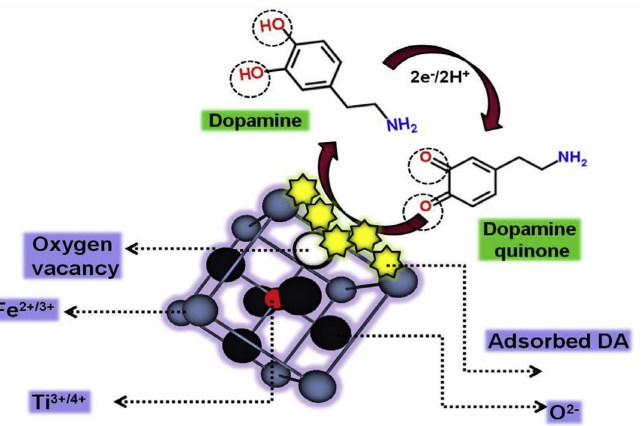
Figure 5. Electrooxidation mechanism of DA on FeTiO 3 [52]. Reproduced with the permission from